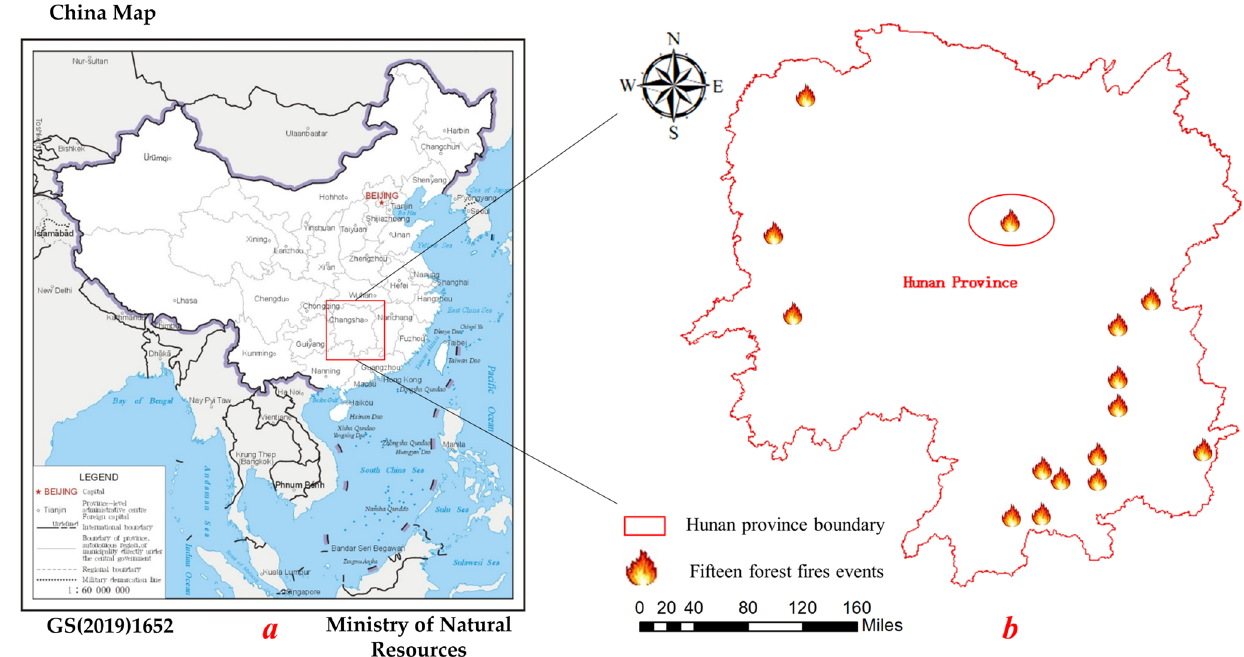
Figure 2. Location of the study area. ( a ) Study boundary within China for which data were down- loaded http://bzdt.ch.mnr.gov.cn/ (accessed on 10 December 2021), ( b ) the 15 forest-fire events in Hunan Province, China as reference data.